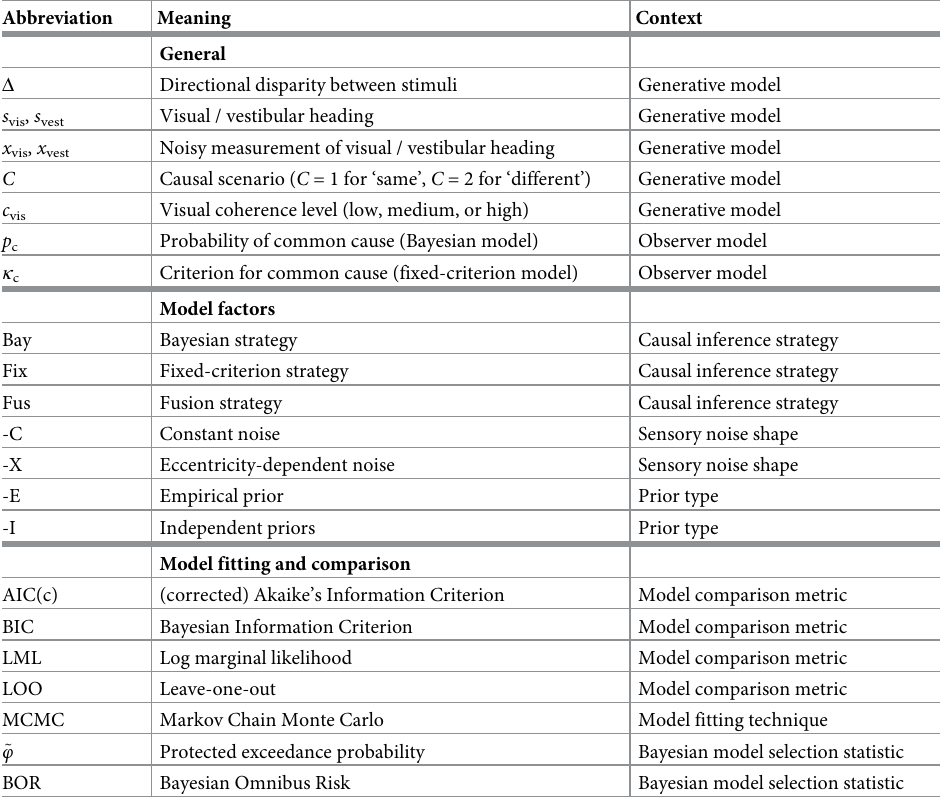
Table 1. Abbreviations and symbols.